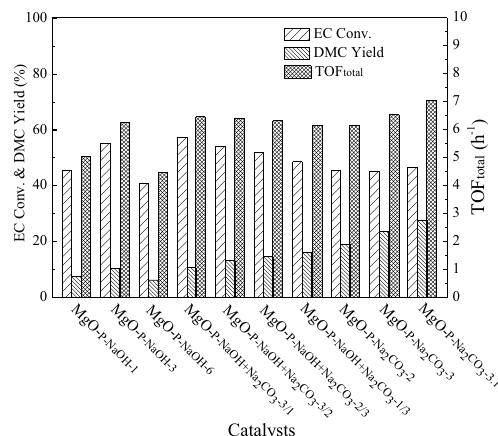
Figure 1. The effect of different precipitant concentrations and types on the catalytic activity. Reaction conditions: EC/MeOH = 1/6, catalyst amount = 3 wt%, reaction temperature = 68 °C, reaction time = 0.5